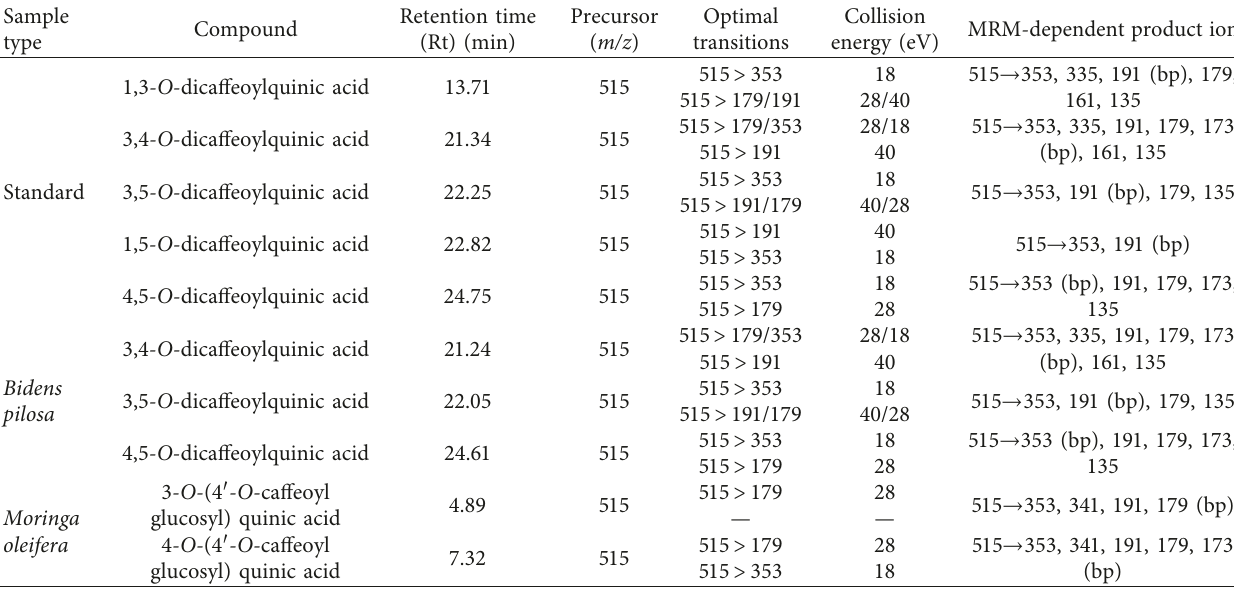
1,3-diCQA, B 3,4-diCQA, C 3,5-diCQA, D 1,5-diCQA, and E 4,5-diCQA. (cid:31) (cid:31) (cid:31) (cid:31) (cid:31)